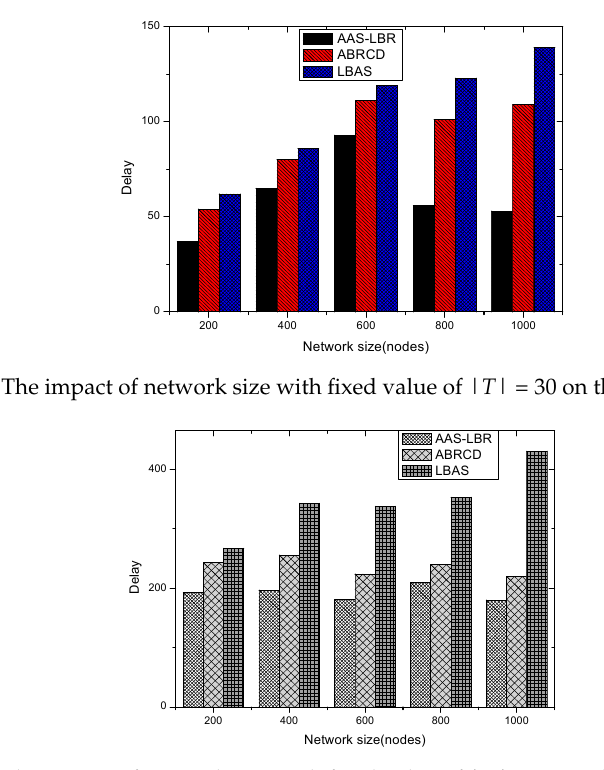
Figure 46. The impact of network size with fixed value of | T | = 150 on the broadcast delay. In networks with 400 and 600 nodes, the propagation delay varies with the value of |𝑇| in Figures 47 and 48. It can be seen that the delay in the AAS-LBR scheme is smaller than the others two schemes. The reason is that in the other two schemes, in order to achieve the purpose of reducing the number of broadcasts, it is necessary to establish a broadcast tree. The first stage of establishing a broadcast tree is to find the MSCN. The broadcast backbone contains all the coverage nodes found in the first stage. The coverage nodes have many neighbor nodes, and these neighbor nodes have independent different active time slots. Therefore, when the program code is spread from the sink node along the broadcast backbone to all nodes, due to the different active slot of the neighbor node, one node needs to broadcast multiple times to transmit data to the neighbor node. In the AAS-LBR scheme, the duty cycle and broadcast radius of the node increase, the number of nodes that establish communication with the node increases, the active time of the neighbor nodes of the node increases, and the active time is earlier. Such a node only needs to broadcast once to broadcast the program code to all neighbor nodes, resulting in a decrease in delay. The broadcast delay in a network with 900 nodes is shown in Figure 49. It can be seen that the delay of the AAS-LBR scheme is smaller than the delay of the ABRCD scheme. The reason is the same as above. The node only needs to broadcast once to transmit the program code to all neighbor nodes, thereby reducing the broadcast delay. The program code transmission delay of AAS-LBR is reduced by 43.09–78.69% compared to LBAS (see Figure 50).